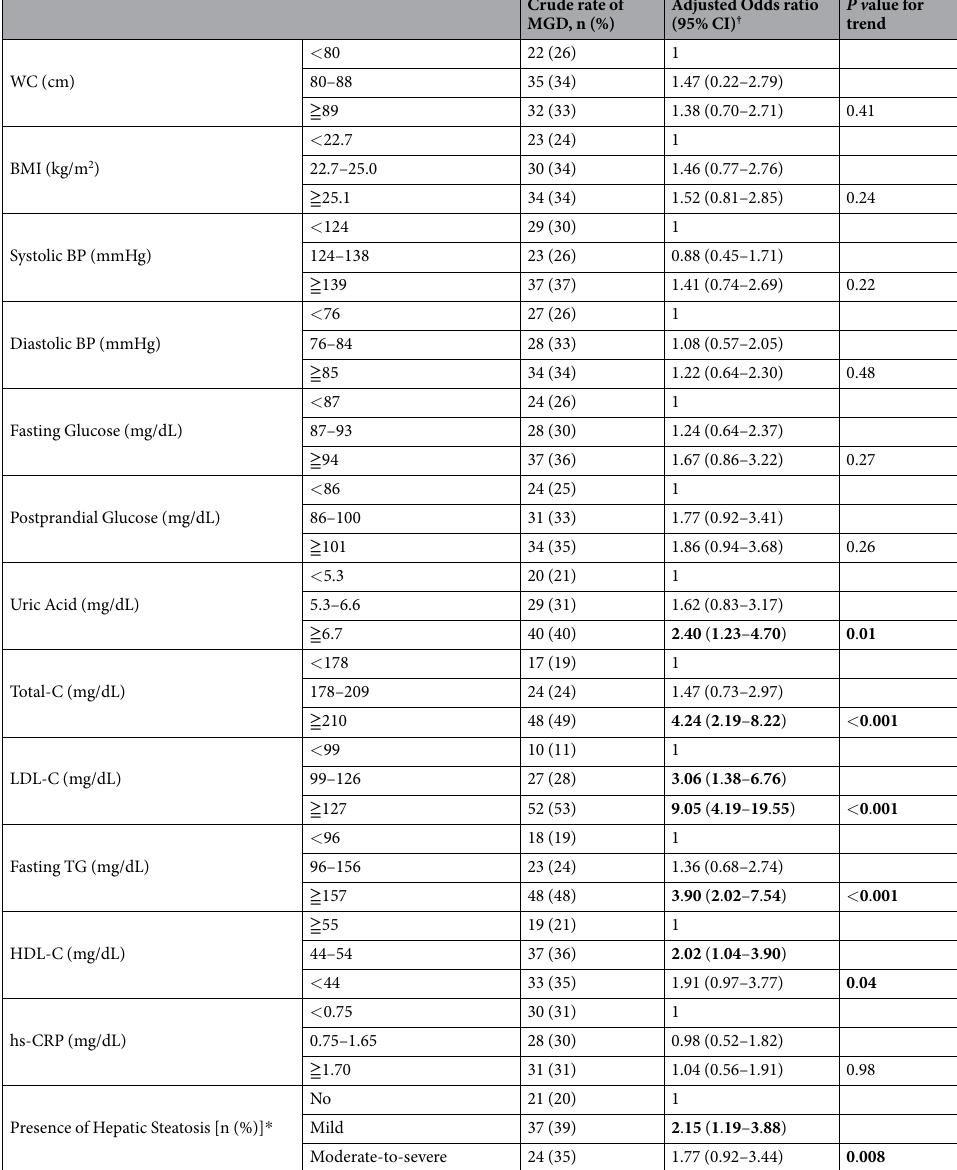
Table 2. Correlations between Asymptomatic Meibomian Gland Dysfunction and Cardiovascular Disease Risk Factors. BMI = body mass index; BP = blood pressure; HDL-C = high-density lipoprotein cholesterol; hs- CRP = high-sensitivity C-reactive protein; LDL-C = low-density lipoprotein cholesterol; MGD =